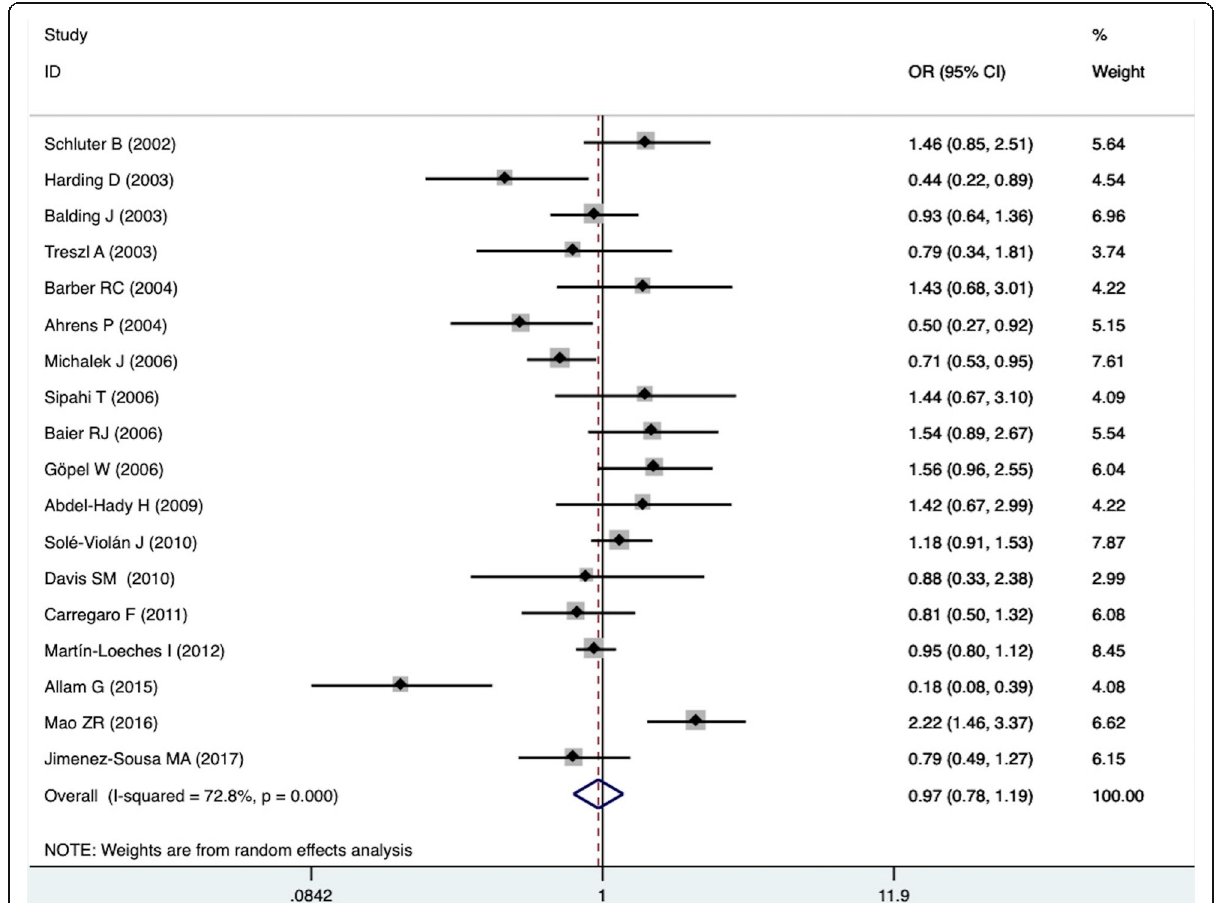
Fig. 2 Forest plot of the association between IL-6 -174 G/C polymorphism and the risk of sepsis under dominant model. The horizontal line represents the 95% confidence interval. And its length shows the range of the confidence interval and the size of the square in the middle shows the weight of the study. The diamond (and broken line) represents the overall summary estimate, with confidence interval given by its width. The unbroken vertical line is at the null value (OR = 1.0). CI, confidence